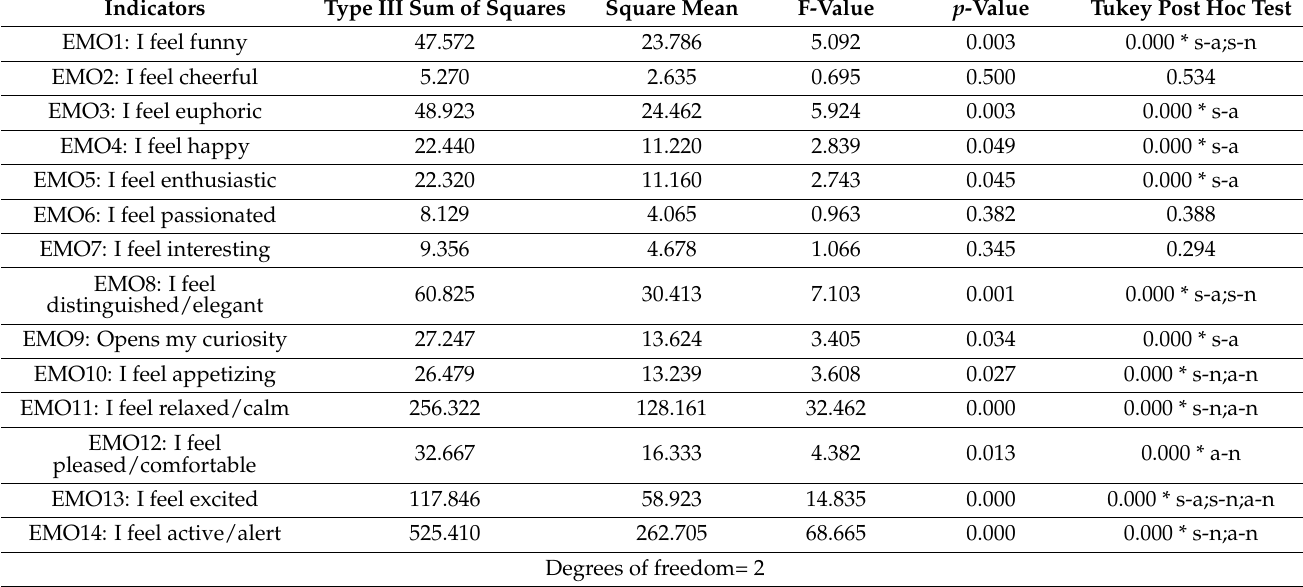
Table 5. Univariate tests and comparisons for positive emotions.